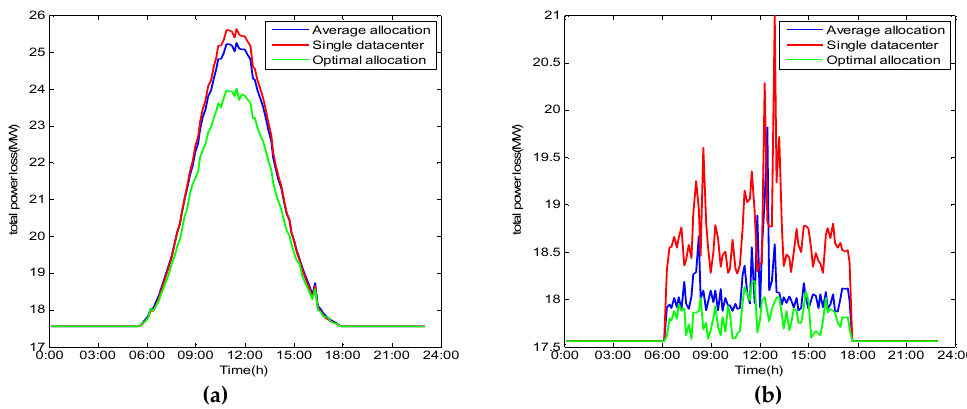
Figure 4. Comparison of loss values over three scenarios. ( a ) sunny day; ( b ) cloudy/snowy day.